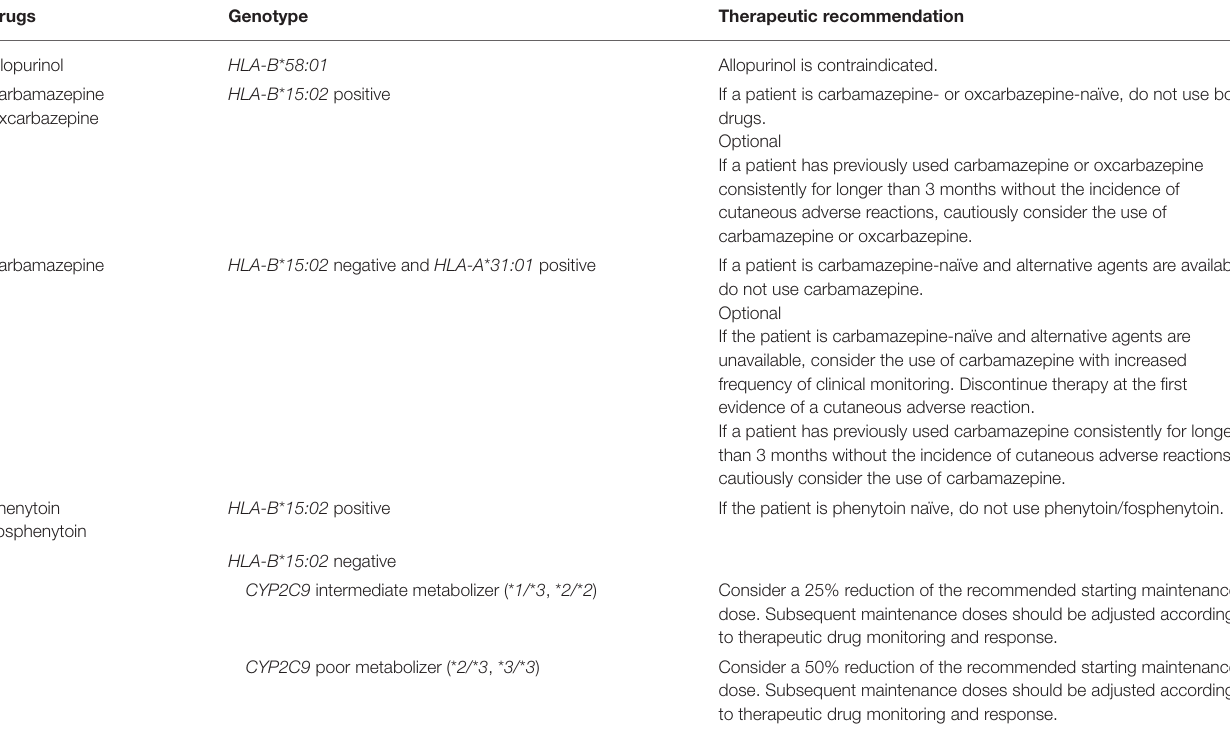
TABLE 2 | Recommendations for therapy based on genotype in CPIC